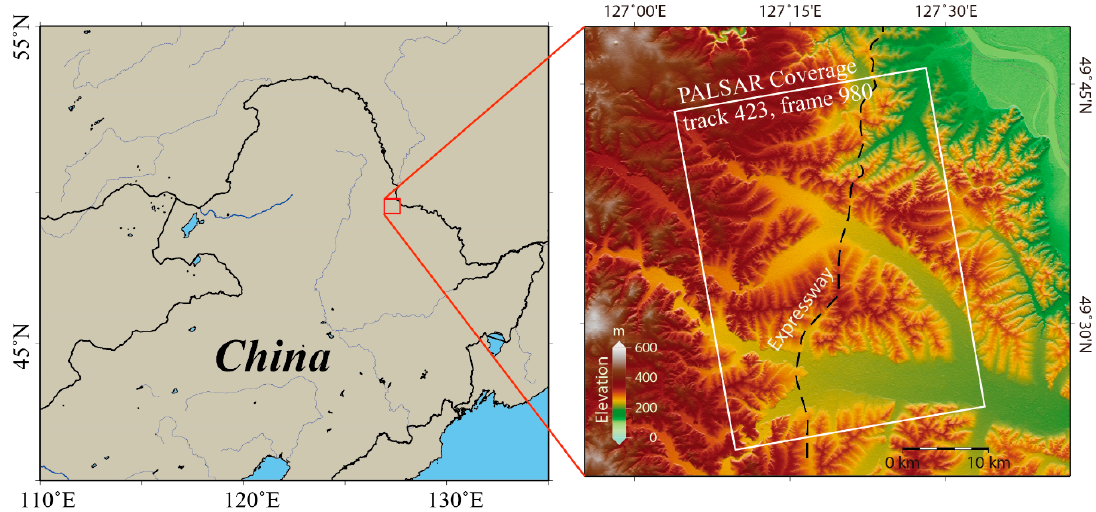
Figure 1. The study area and its Digital Elevation Model (DEM). The red rectangle on the left outlines the spatial coverage of the study area, and the right inset shows the DEM of the study area, with the bold black dashed line denoting the expressway from Bei’an to Heihe and the white rectangle denoting the coverage of the ALOS/PALSAR data used in this